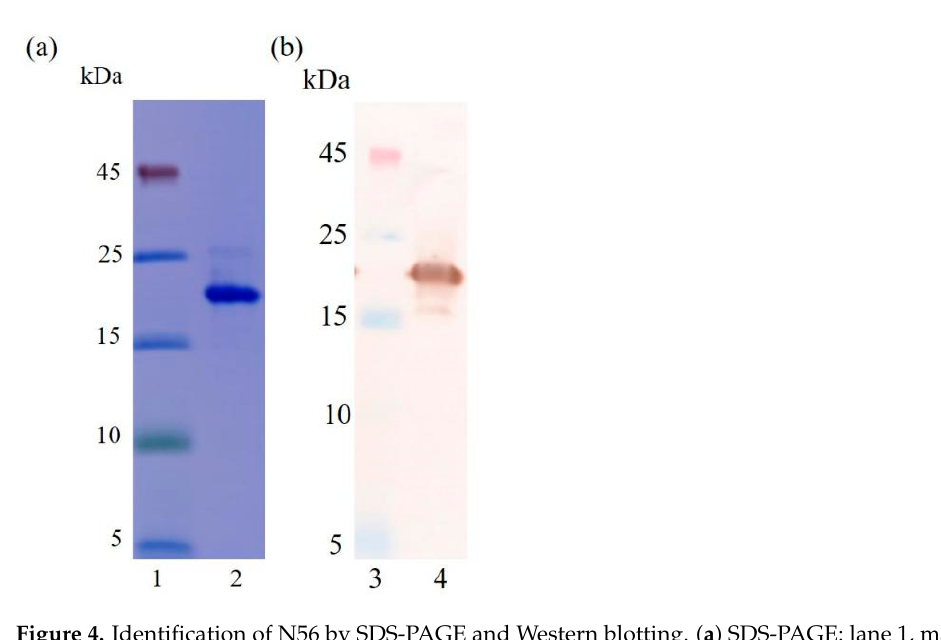
Figure 4. Identification of N56 by SDS-PAGE and Western blotting. ( a ) SDS-PAGE: lane 1, marker; lane 2, purified N56. ( b ) Western blotting: lane 3, marker; lane 4, purified N56.